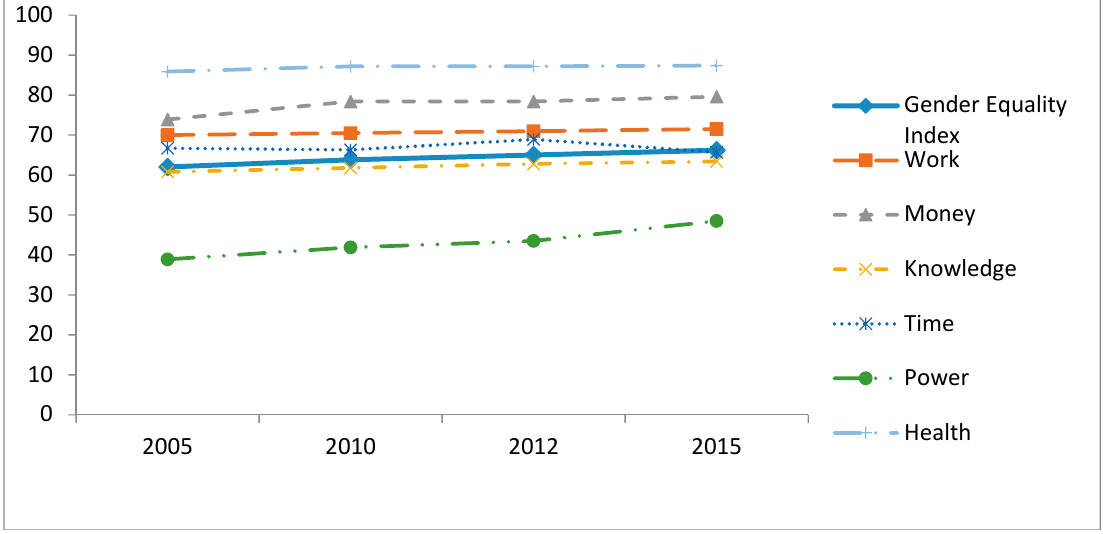
Figure 1. EIGE Gender Equality Index EU28 2005–2015 (EIGE 2017a).